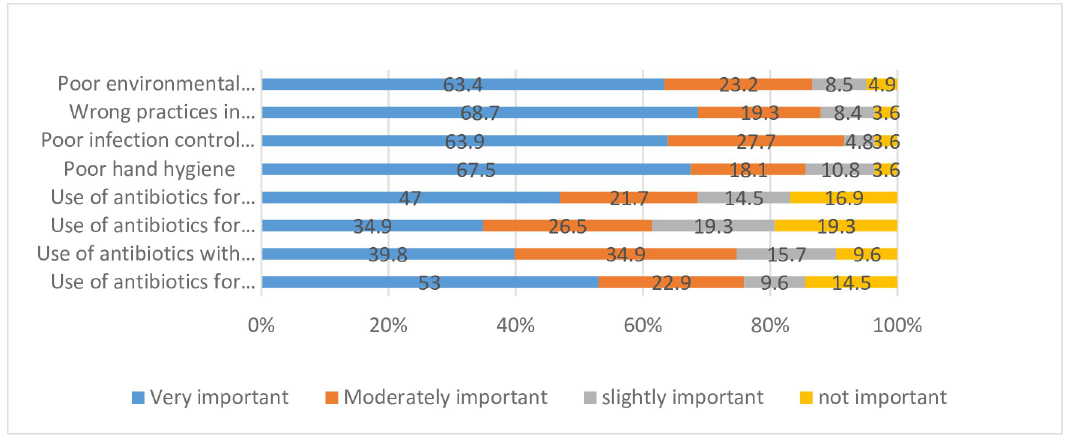
Fig 1. Perception of physicians regarding contributing factors to the development or spread of antimicrobial resistance.